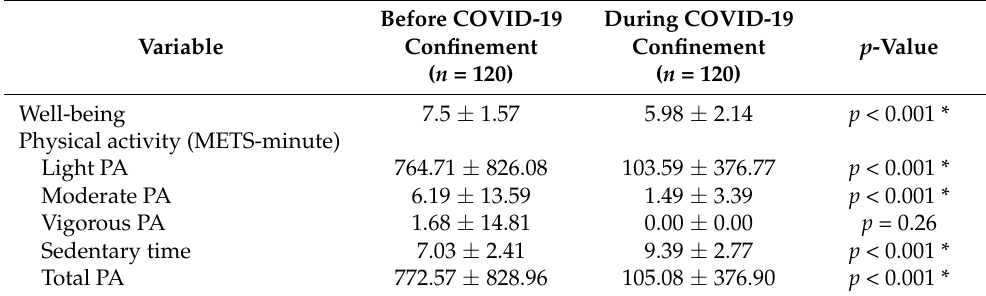
Table 3. Well-being and physical activity of older patients with HF before and during COVID-19